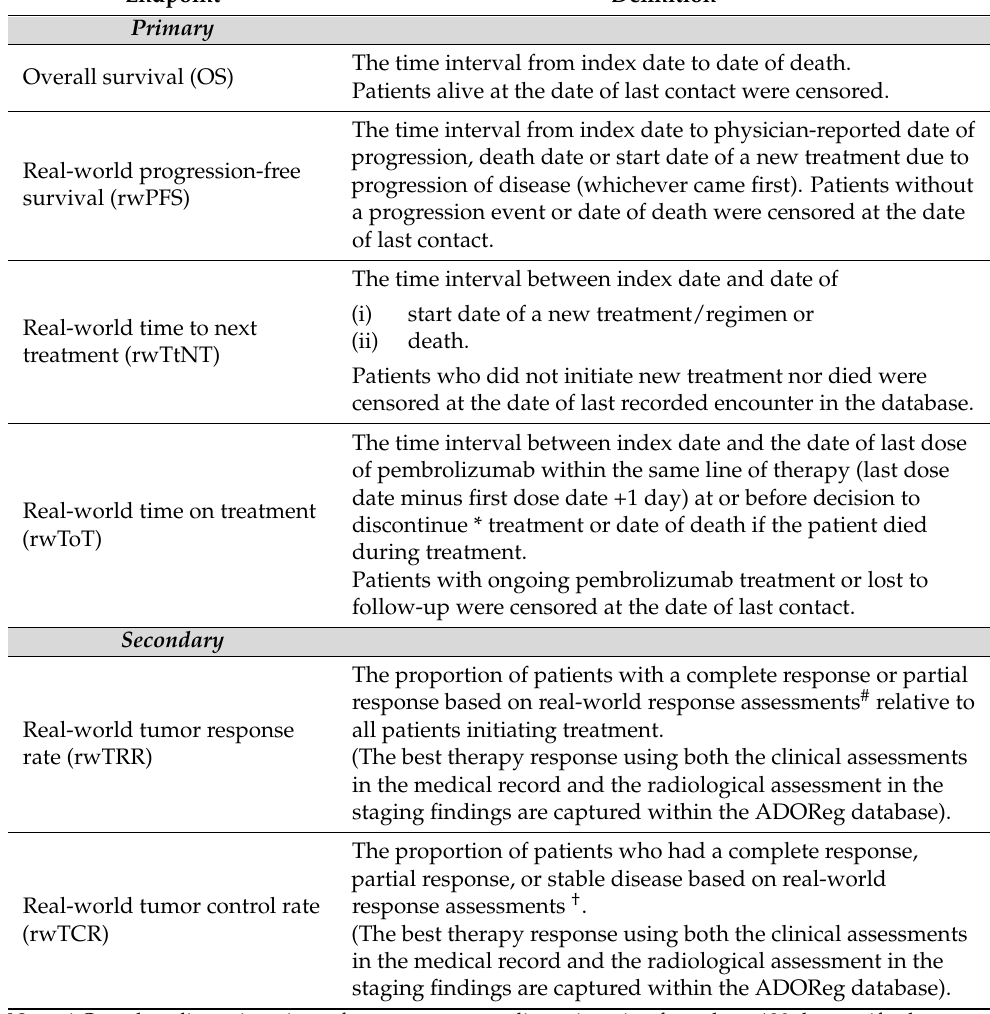
Table 1. Definition of real-world endpoints used in this